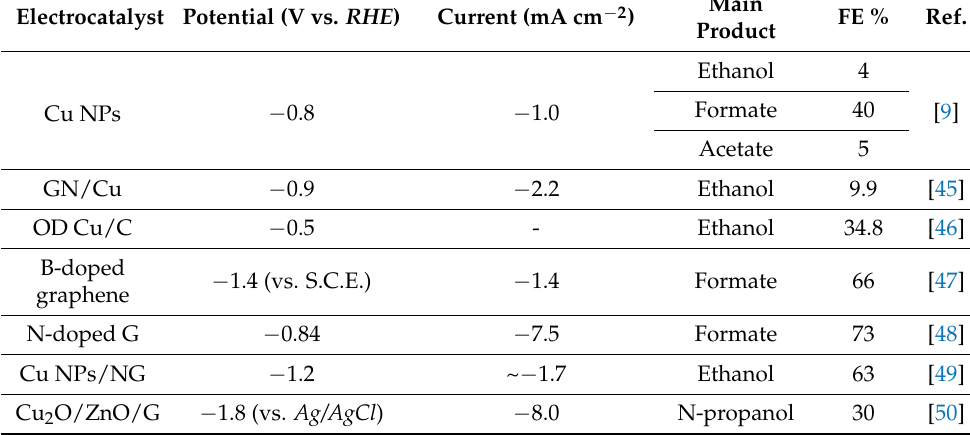
Figure 9. ( a ) FEs. ( b ) Production rate of the liquid products by Cu/NC-700 at the function of poten- tial. Table 1. Comparison of the catalytic performances of Cu/NC-700 and the similar electrocatalysts reported in literature for the reduction of CO 2 to liquid products.